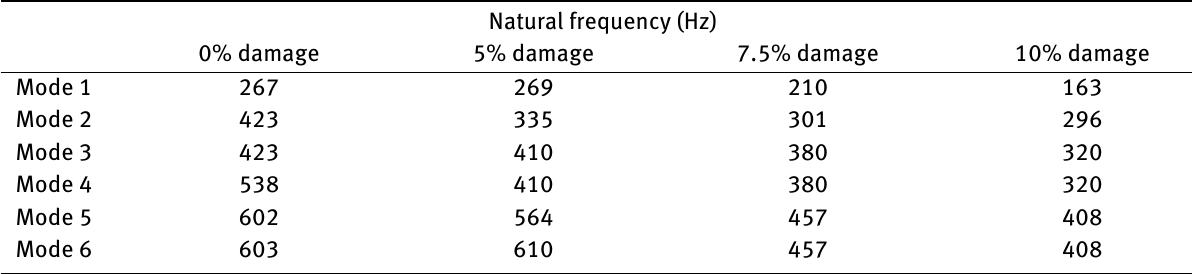
Table 2: Natural frequency (Hz) of the ship sandwich plate in the first sixth mode.